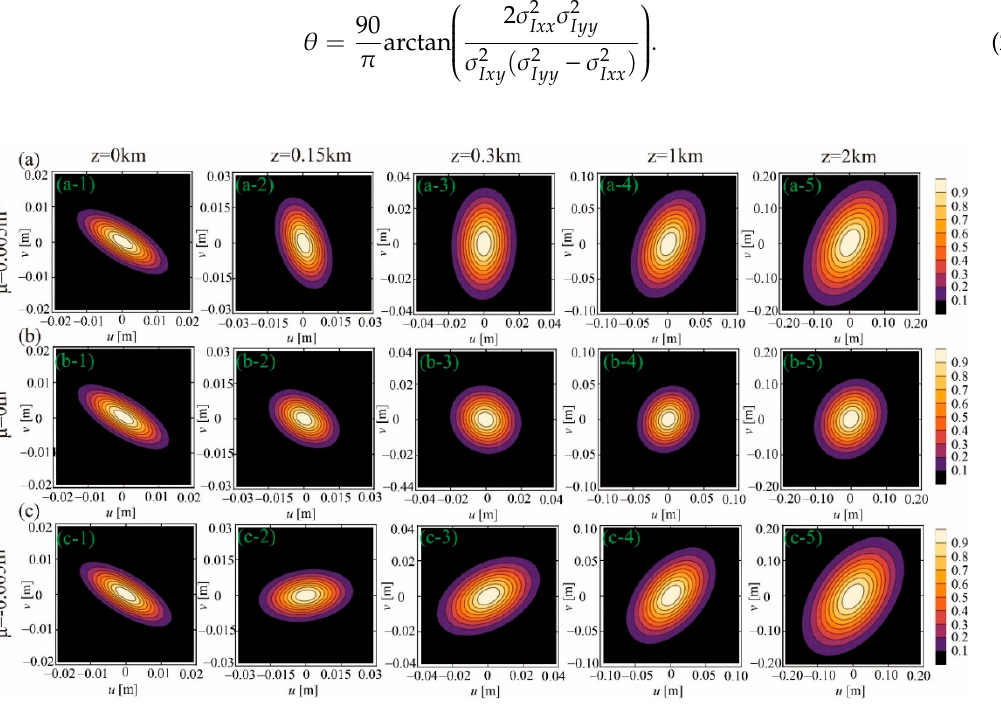
Figure 1. Normalized spectral densities (contour graph) of a TAGSM beam at several propagation distances z in free space for di ff erent values of the initial twist factors. ( a ) µ = 0.005 m − 1 ; ( b ) µ = 0 m − 1 ; ( c ) µ = − 0.005 m − 1